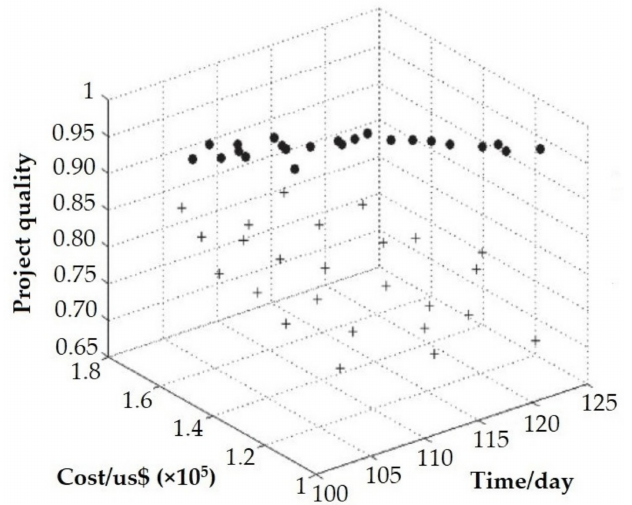
Figure 5. Comparison of optimization results. + Optimized results obtained by Mungle et al. [12], • Opti-mized results obtained in this